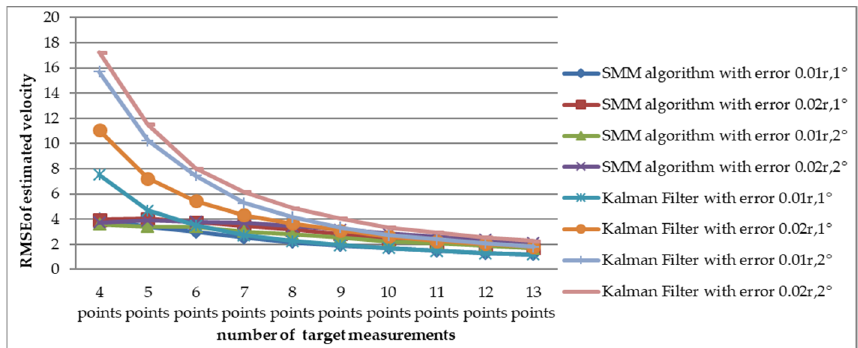
Figure 9. Comparison of estimated velocity RMSE between SMM algorithm and adaptive Kalman filter versus different detection error (Scenario 7).